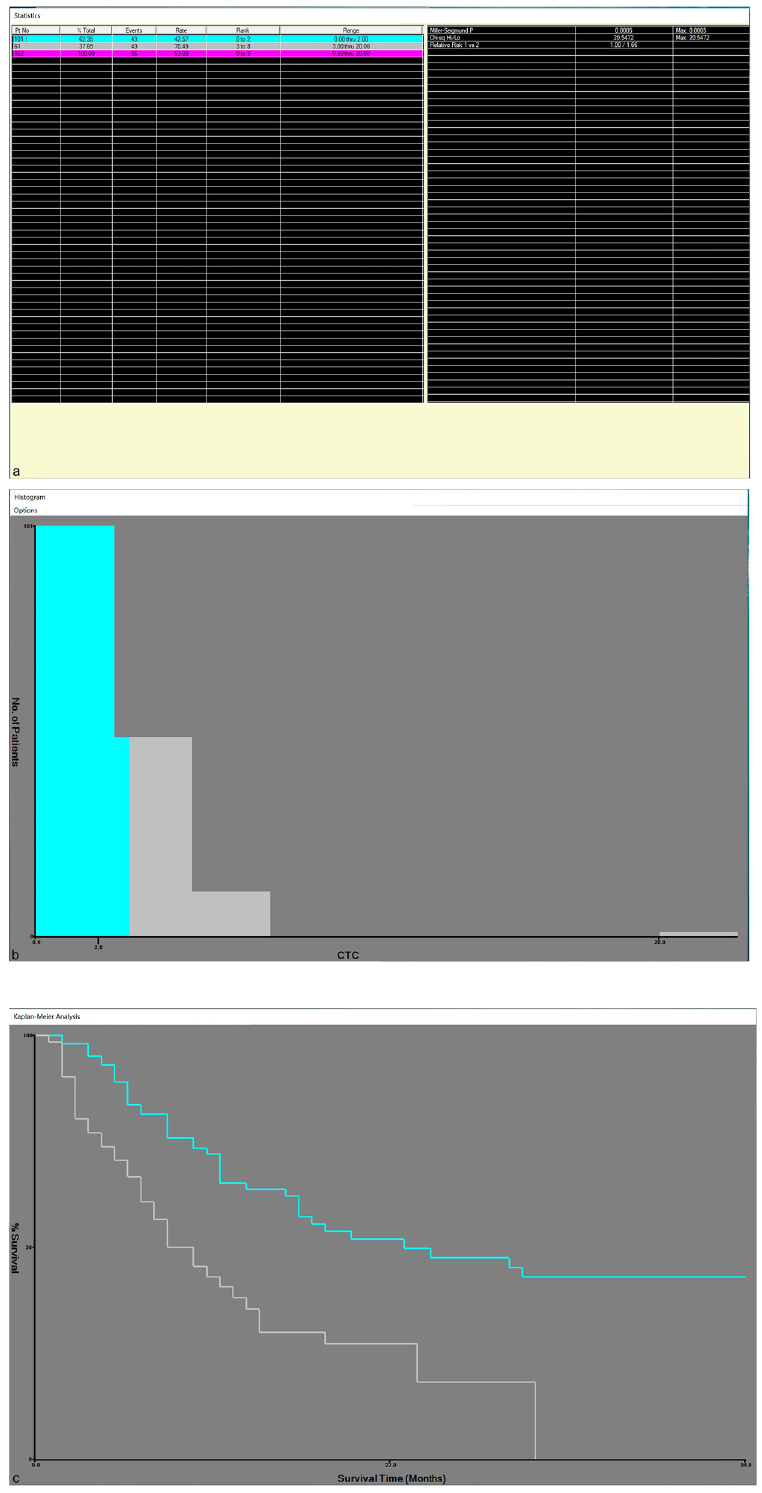
Figure 1. X-tile plots of preoperative CTCs and tumor-free survival of patients with HCC after percutaneous RFA. X-tile plots showing χ 2 values with cut-off points to generate low- and high-CTC subgroups. ( a ) The optimal cut-off value of the CTCs was 2/3.2 mL at the maximum χ 2 value of 20.5472. ( b) Histogram of the entire cohort divided into low-CTC and high-CTC subgroups according to the optimal cut-off value of 2/3.2 mL. Blue bars represent the low-CTC group, and grey bars represent the high CTC group. ( c ) Kaplan– Meier plot of tumor-free survival in groups stratified using the optimal cut-off value of CTCs. Blue curves represent the low-CTC group, and grey curves represent the high-CTC group. RFA Radiofrequency ablation; HCC Hepatocellular carcinoma; CTC Circulating tumor